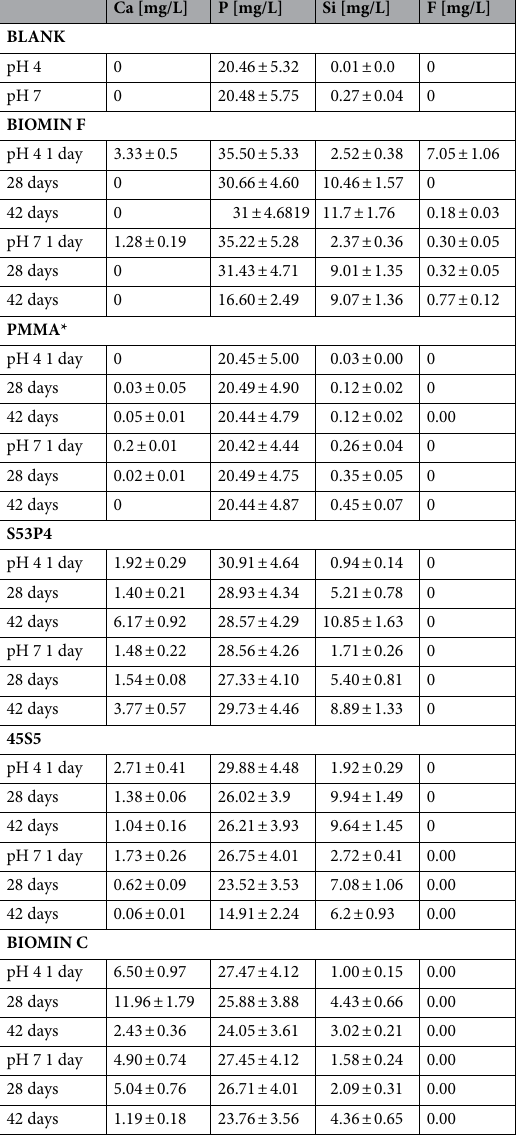
Table 4. Results of ions released after a long period in artificial saliva. The phosphate and silica ion values were calculated from the difference between the test result and the blank values for the respective pH. *Phosphate and a small amount of silicon and calcium come from saliva as well as from the surface of the samples, which were thermally polymerized in tap